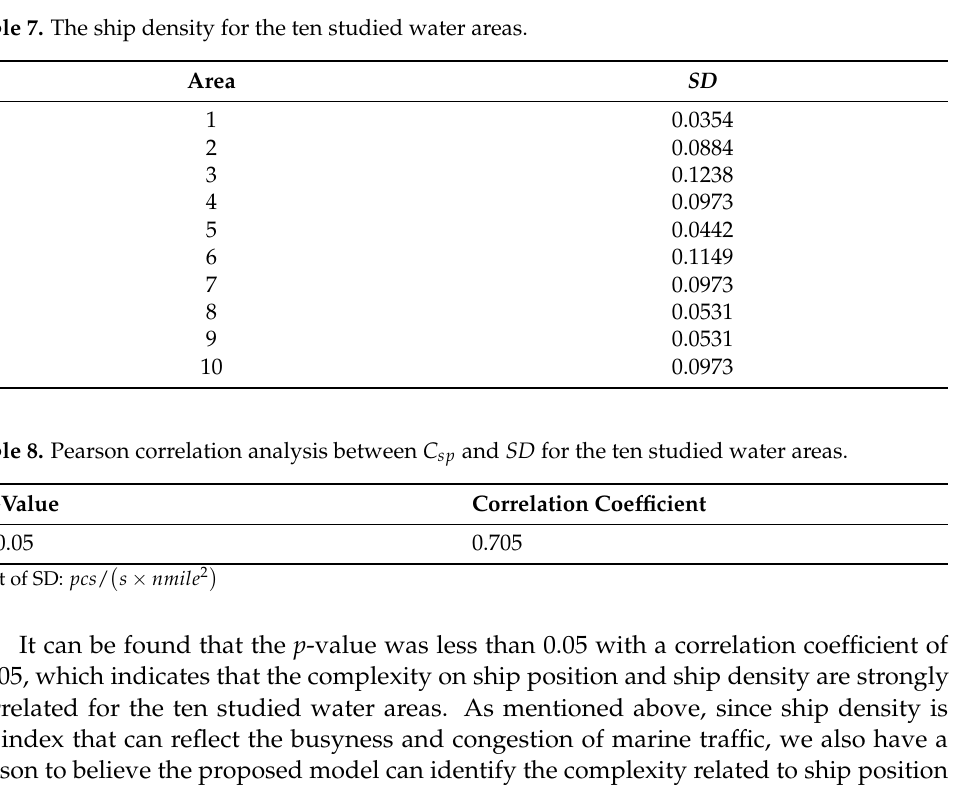
Table 7. The ship density for the ten studied water areas.